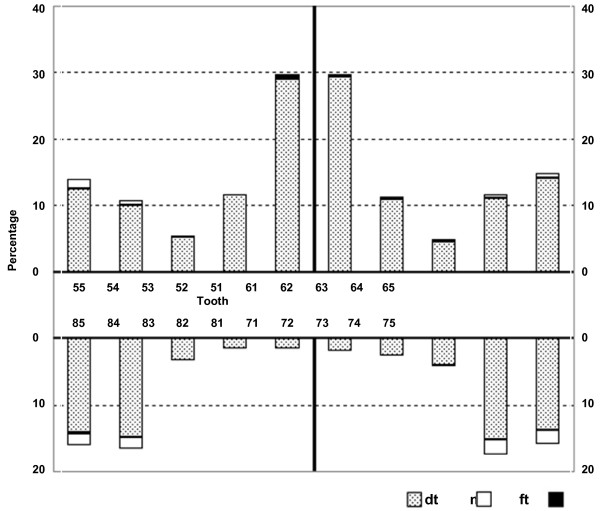
Distribution of caries experience of children (N = 700).